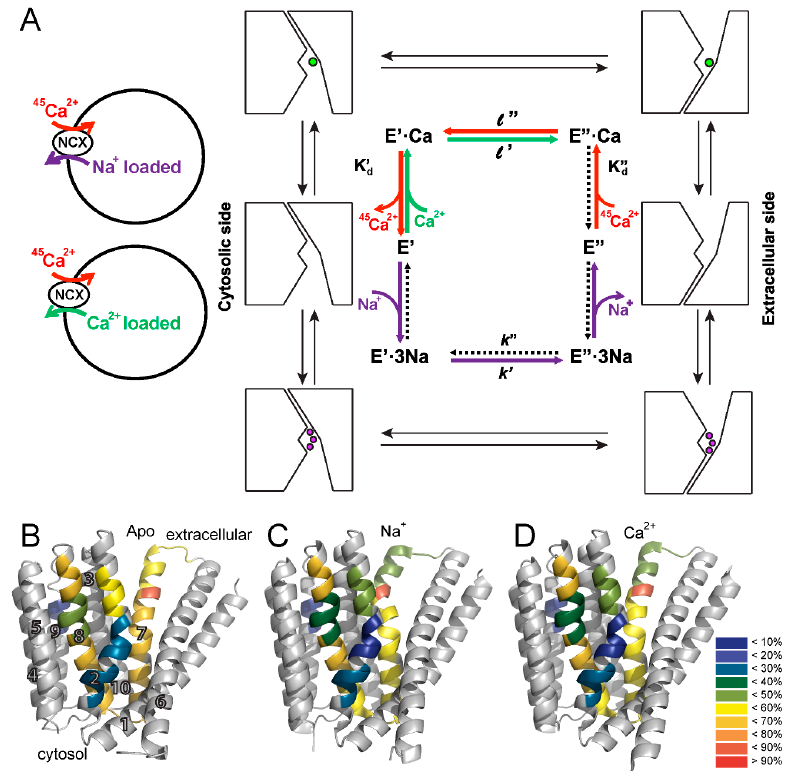
Figure 3. Ion transport cycle and NCX backbone dynamics. ( A ) schematic representation of the ion-flux assay for the Na + / 45 Ca 2+ exchange or the Ca 2+ / 45 Ca 2+ exchange and the ping-pong mechanism describing the exchange reactions. The red , green , and purple arrows represent Ca 2+ -entry, Ca 2+ -exit, and Na + -exit steps of the transport cycle, respectively. The dotted arrows represent the reactions of the transport cycle, which negligibly contribute to the observed ion-exchange reactions under the given experimental conditions. The K ’ d and K” d values represent the dissociation constants for Ca 2+ binding to NCX_Mj at the cytosolic and extracellular sides, respectively; and ( B – D ) the heat map after a 1200 s exchange is overlaid on the crystal structure of NCX_Mj for the apo (PDB 5HXH, B ), Na + -bound (PDB 5HXE, C ), and Ca 2+ -bound (PDB 5HXR, D ) forms. The color key indicates the HDX level. The numbers indicate the transmembrane helix number.